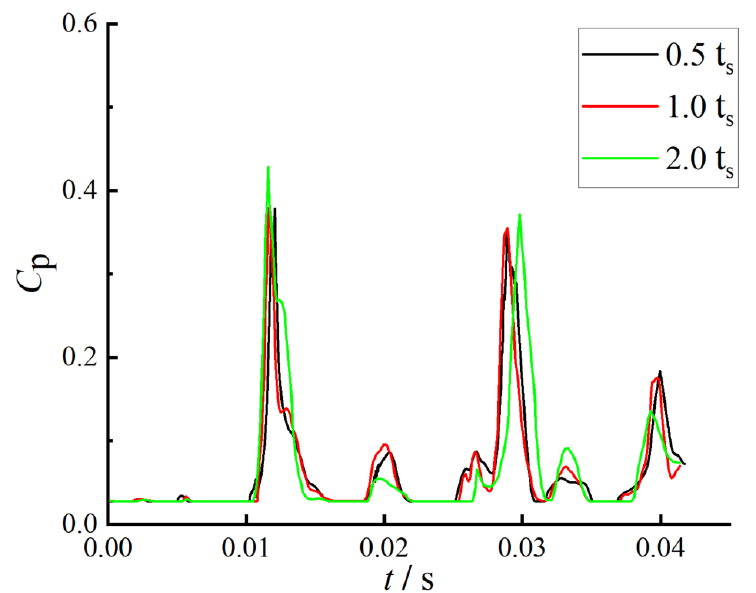
Figure 5. Time history curves of Cp with three different time steps ( Q = 0.8 Q BEP , σ = 0.35). The time-averaged value of the pump head H obtained via the transient